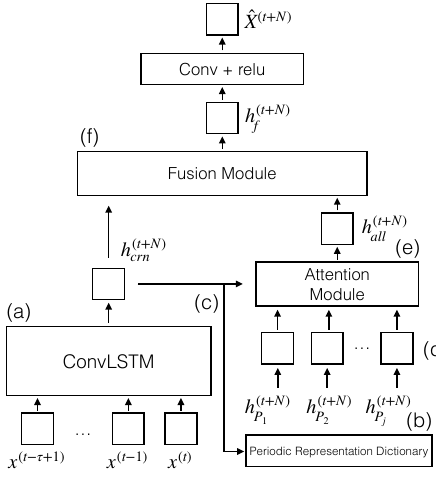
Figure 2. The SP-CRN (LSTM) architecture. ( a ) the CRN component, ( b ) the PRD, ( c ) update mechanism, ( d ) load mechanism, ( e ) the attention module, and ( f ) fusion